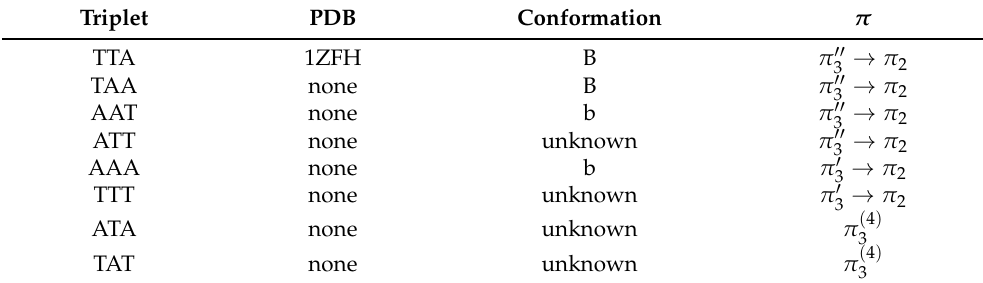
are as in (Table 5 in [4]). The card seq for 3 , it is [ 1,7,50,739,15234,548439, · · · ] ; for π 3 and π (cid:48) may be simplified to a group whose card seq is that of 3 3